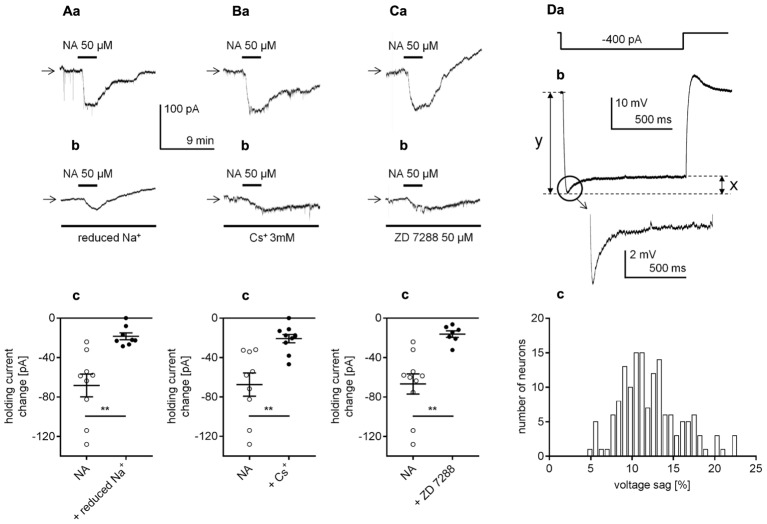
Identification of the cellular effector responsible for the β1-adrenergic receptor-dependent inward current in layer V mPFC pyramidal neurons. (A) Inward currents evoked by bath application of NA alone (50 μM, a) and by NA (50 μM) in the presence of a reduced Na+ concentration in the extracellular solution (b). Amplitude of the holding current change evoked by 50 μM NA alone (NA) and 50 μM NA in the presence of a reduced extracellular Na+ concentration (+ reduced Na+, c). (B) Inward currents evoked by bath application of NA alone (50 μM, a) and by NA (50 μM) in the presence of Cs+ (3 mM in the bath, b). Amplitude of the holding current change evoked by 50 μM NA alone (NA) and 50 μM NA in the presence of 3 mM Cs+ (+ Cs+, c). (C) Inward currents evoked by bath application of NA alone (50 μM, a) and by NA (50 μM) in the presence of ZD 7288 (50 μM in the bath, b). Amplitude of the holding current change evoked by 50 μM NA alone (NA) and 50 μM NA in the presence of 50 μM ZD 7288 (+ ZD 7288, c); ∗∗p < 0.01. (D) The membrane potential change (b) evoked by rectangular negative current steps (-400 pA, lasting 1000 ms, a). Amplified voltage sag shown in the inset. Histogram of the voltage sag size [%] in layer V mPFC pyramidal neurons (c). The size of the voltage sag was calculated by the difference between the maximum amplitude and sustained current response (x in Db) as a percentage of the maximum current response (y in Db).